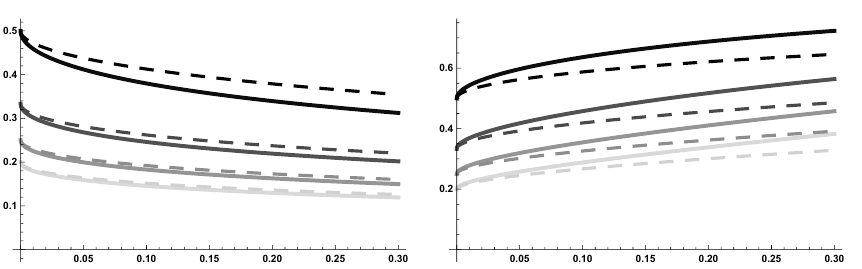
Figure 4. Solutions of C D β u − u = − u p + 1 (on the left ) and of D β u + u = u p + 1 (on the right ) with β = u 0 = 1/2 and p = 1,2,3. Darker lines correspond to bigger p ’s.